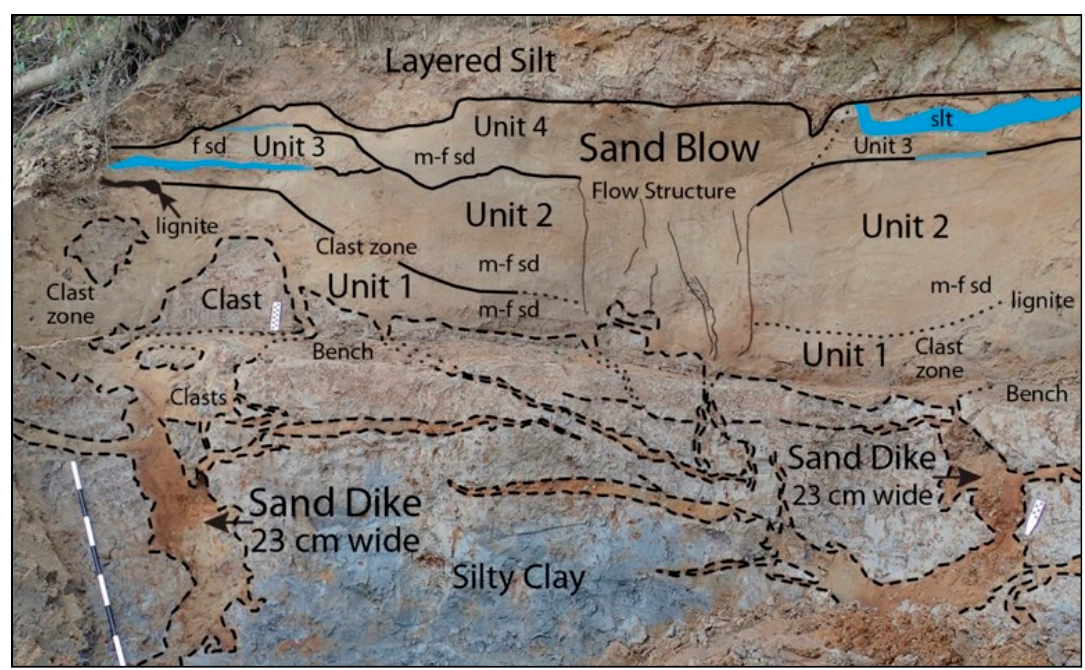
Figure 15. Annotated photograph of liquefaction features exposed in a river cutbank in the vicinity of the New Madrid seismic zone in the central US [117]. Two 23-cm-wide sand dikes with multiple splays crosscut silty clay and connect with the base of a large compound sand blow, composed of four depositional units, that formed during four earthquakes in a sequence. Dashed lines represent clear contacts; dotted lines represent inferred contacts; solid lines represent clear contacts of sand blow units; blue represents silt layers at top of sand blow units. The black and white intervals on the meter sticks represent 10 cm. Photograph by M. Tuttle.